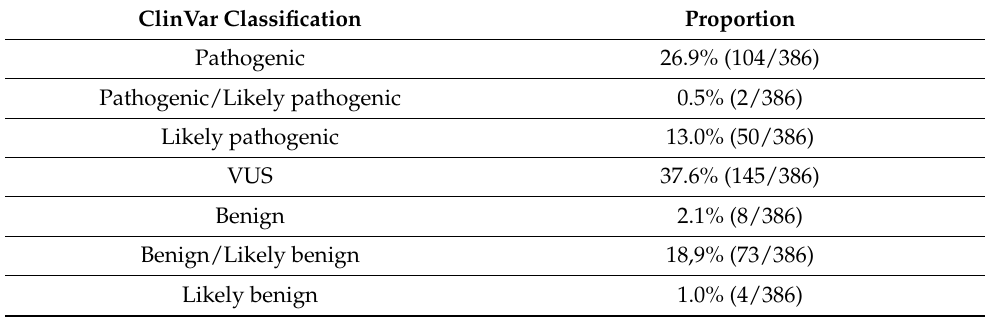
Table 5. Proportion of classified